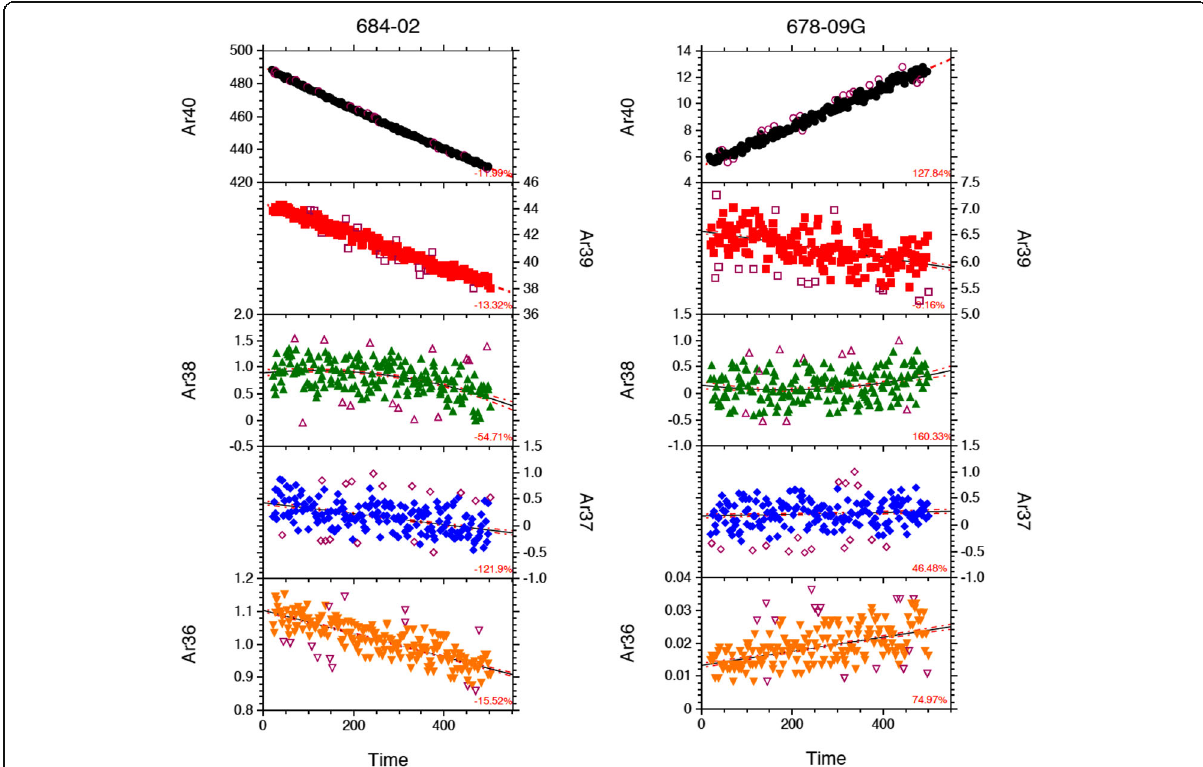
Fig. 1 Normal behavior of Ar isotopes during measurement. All isotope signals are expected to decrease (left) due to the ionization by electron bombardment in the ion source chamber. For samples with small Ar contents (right), the increasing trends are prominent. The red numbers represent the variation of each isotope signal at the beginning and end of the